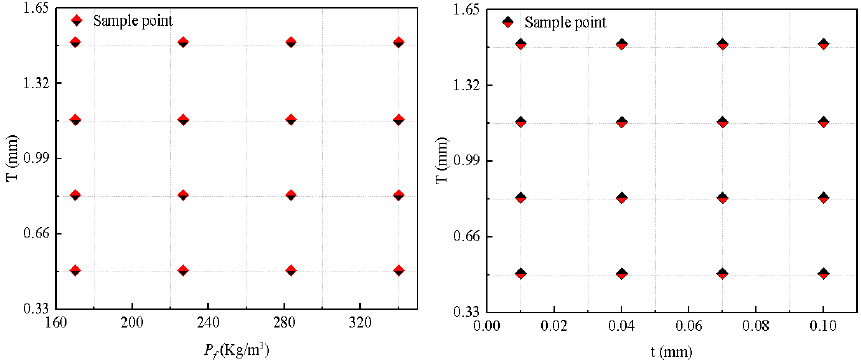
Figure 10. Design sample points of FB and HF.